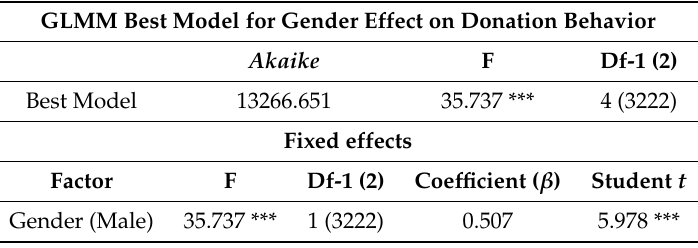
Table 3. Gender effects on Donation